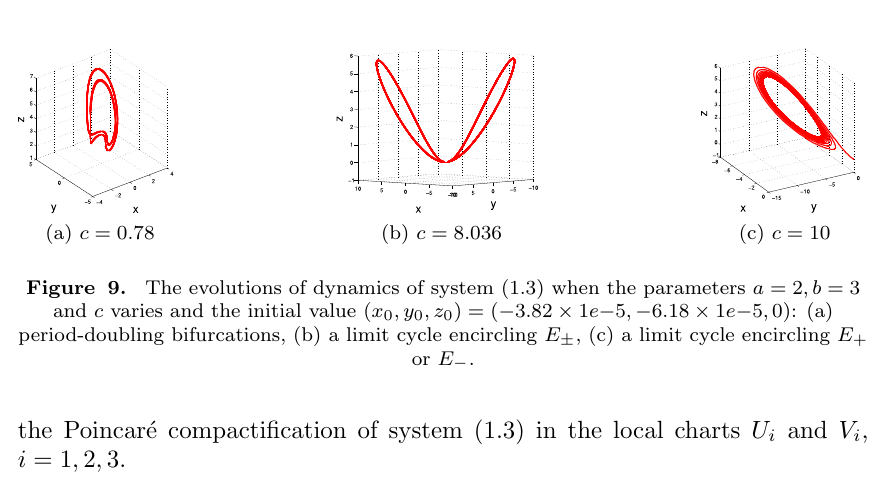
Figure 8. Two heteroclinic orbits of system (1.3) when ( x 0 ,y 0 ,z 0 ) = ( ± 3 . 82 × 1 e − 5 , ± 6 . 18 × 1 e − 5 , 0), ( a,b ) = (2 , 3), different values of c and time of integration: [0 , 750].